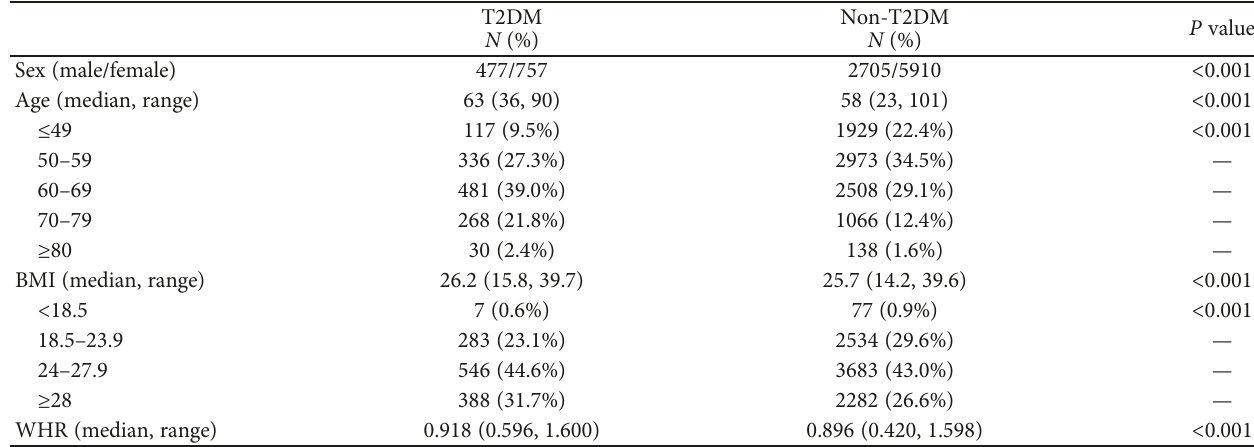
Table 1: Characteristics of the